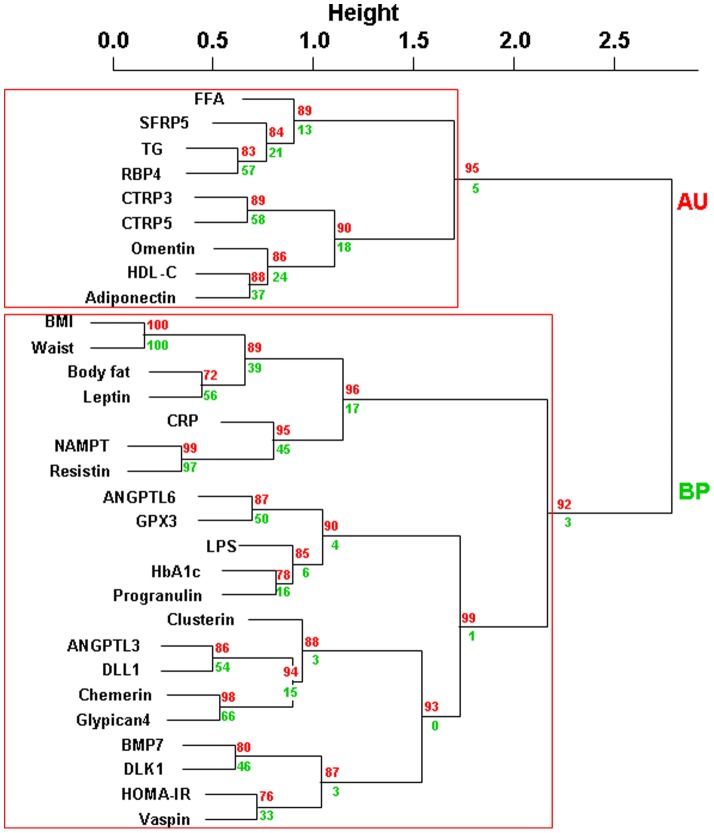
Hierarchical clustering of serum adipokine concentrations and clinical parameters in patients with type 2 diabetes (n = 69).We provide approximately unbiased (AU) p-values and bootstrap probability (BP) values as measures of certainty for clusters. Values are based on 10,000 bootstrapping replicates. AU≥90% was considered as strong evidence for the cluster and is marked by red rectangles (only largest possible clusters are marked). Abbreviations: BMI, body mass index; HOMA-IR, Homeostatic Model Assessment; FFA, free fatty acids; CRP, high sensitive C-reactive protein; ANGPTL 3, angiopoietin-like protein 3; ANGPTL 6, angiopoietin-like protein 6; BMP7, bone morphogenetic protein 7; CTRP3, complement C1q tumor necrosis factor-related protein 3; CTRP5, complement C1q tumor necrosis factor-related protein 5; LPS, Lipopolysacharid (Endotoxin); GPX3, glutathione peroxidase 3; DLL1, delta-like protein 1; DLK1, preadipocyte factor 1; NAMPT, nicotinamide phosphoribosyltransferase (visfatin); RBP4, retinol binding protein 4; SFRP5, secreted frizzled-related protein-5; TG, triglycerides.